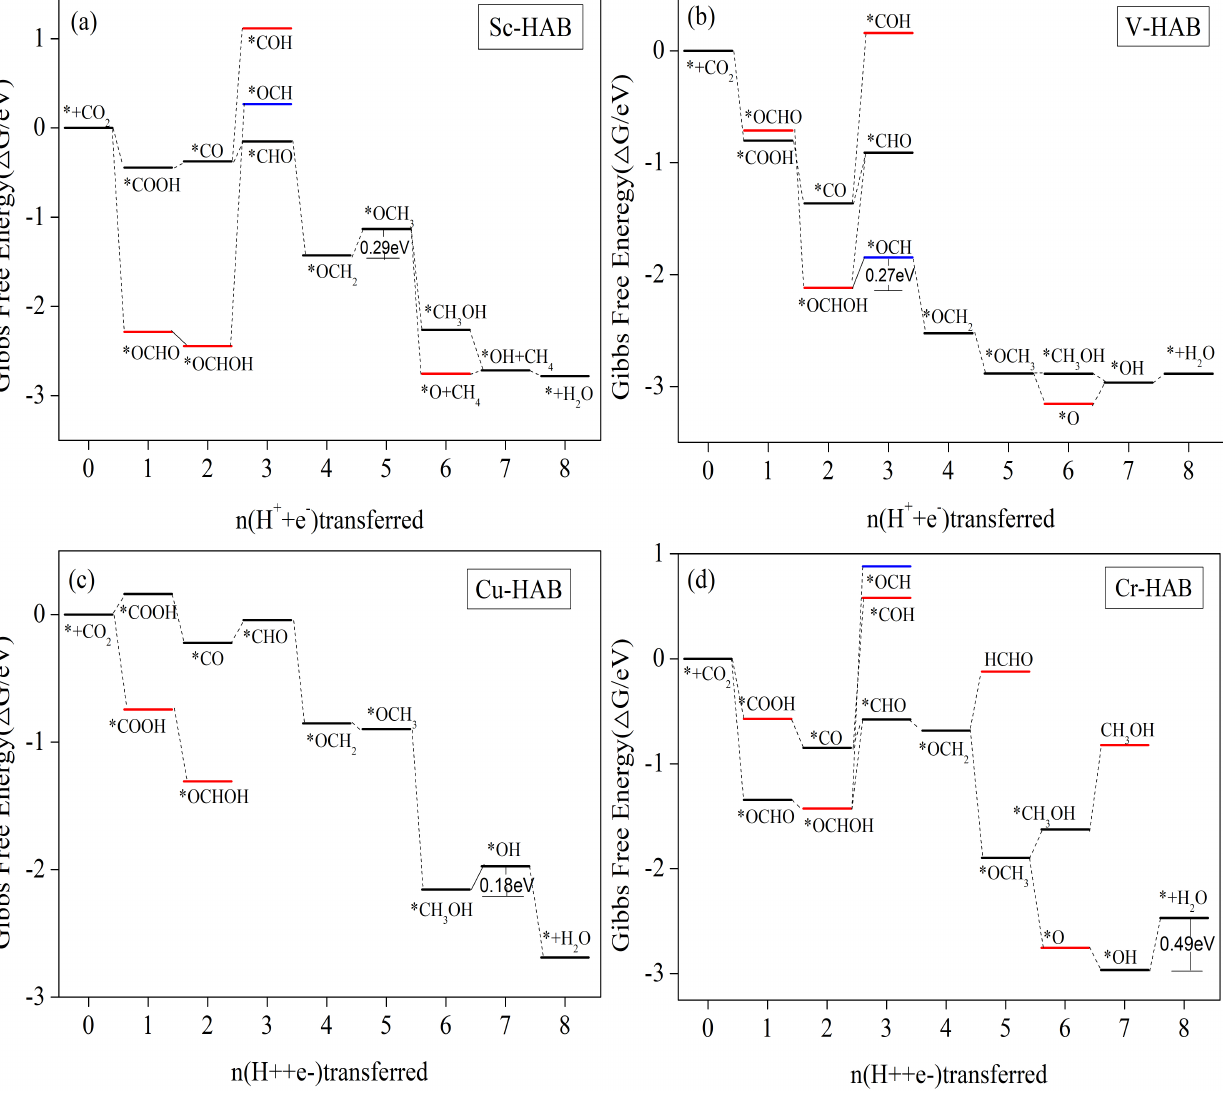
Figure 8. Gibbs free energy profiles for the CRR along the most favorable pathways for ( a ) Sc–HAB, ( b ) V–HAB, ( c ) Cu–HAB, and ( d ) Cr–HAB at zero potential. The free energy zero is set to a CO 2 molecule in the gas phase with a clean catalyst